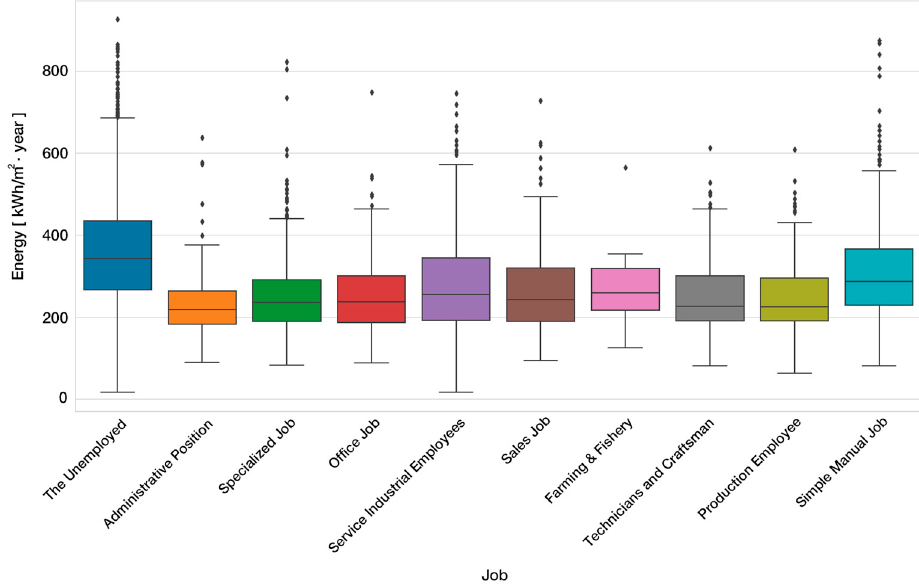
Figure 10. Comparison of energy consumption according to occupational status